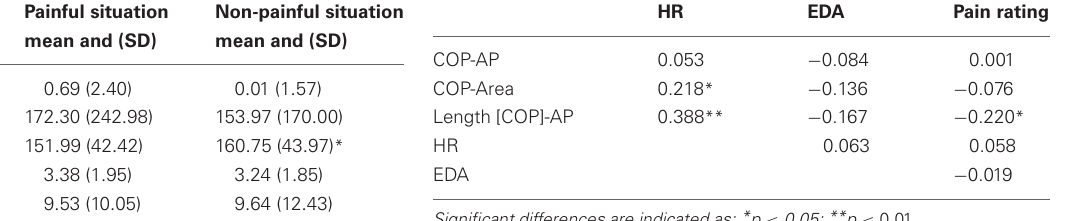
FIGURE 1 | (A) Pain ratings (Mean and SD) as a function of stimuli (Painful vs. Non-painful). Significant differences are indicated as: † p < 0 . 001; (B) Means and SDs of the anteroposterior length as a function of stimuli (painful vs. non-painful); (C) Means and SDs of electromyographic data for Soleus (SO) and Tibialis Anterior (TA)